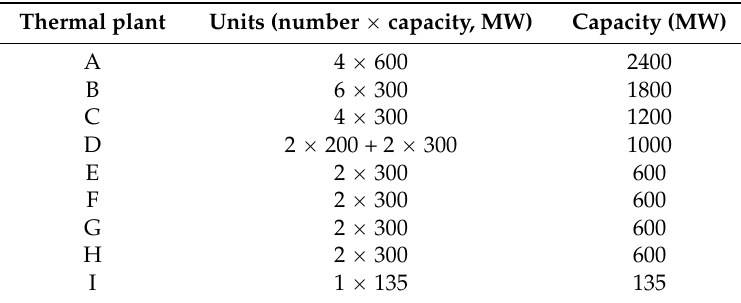
Table 1. Thermal power system in Yunnan power grid